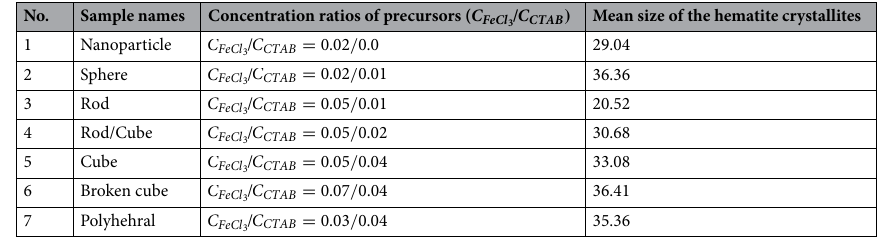
Table 1. Concentration ratios of precursors, mean size of the hematite crystallites synthesized via hydrothermal